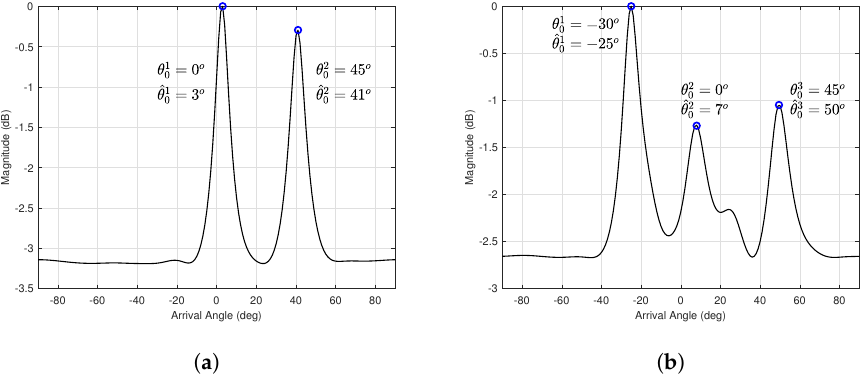
Figure 9. Estimated DOA for multiple persons associated with the first realization. ( a ) For two persons. ( b ) For three persons.